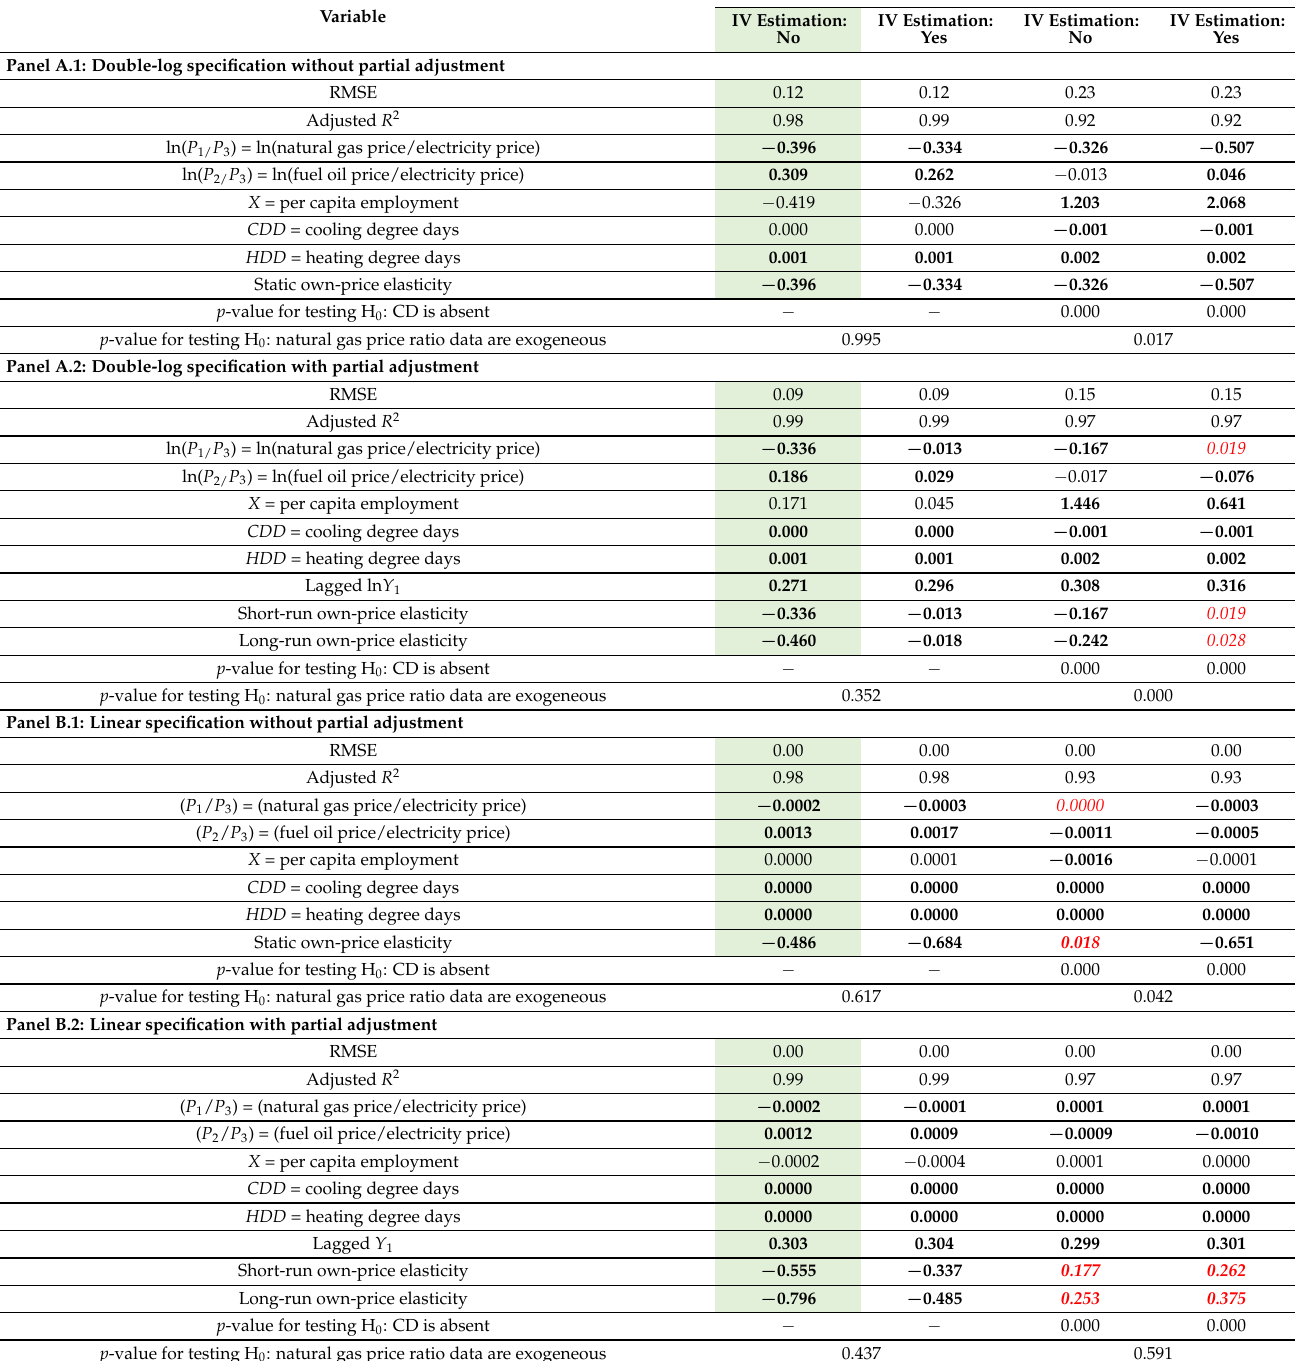
preferred regression results by specification, which are shaded in light green in the panels of Table 4. All preferred regressions are based on CD presence and non-IV estimation. Table 4. Regression results by specification; coefficient and elasticity estimates which are statistically significant ( p -value ≤ 0.10) are in bold ; coefficient and elasticity estimates with an unexpected sign are in italic ; and each specification’s preferred results shaded in light green